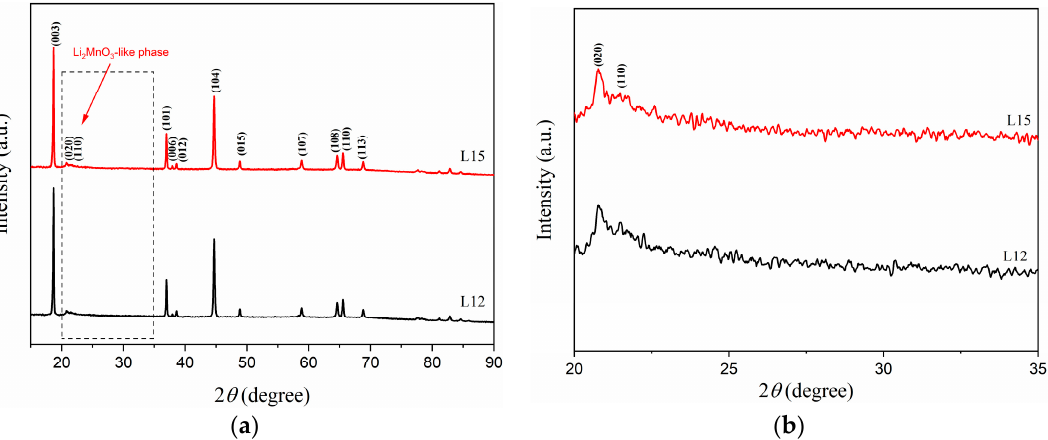
Figure 5. ( a ) XRD pattern of synthesized material with different lithium sources: LiOH and Li 2 CO 3 ; ( b ) Magnified rectangle region in ( a ): superlattice peaks of C2/m Li 2 MnO 3 in the 2 θ range of 20–25°. Table 5. Lattice parameters of samples L10–L13 for existence of the monoclinic Li 2 MnO 3 phase.